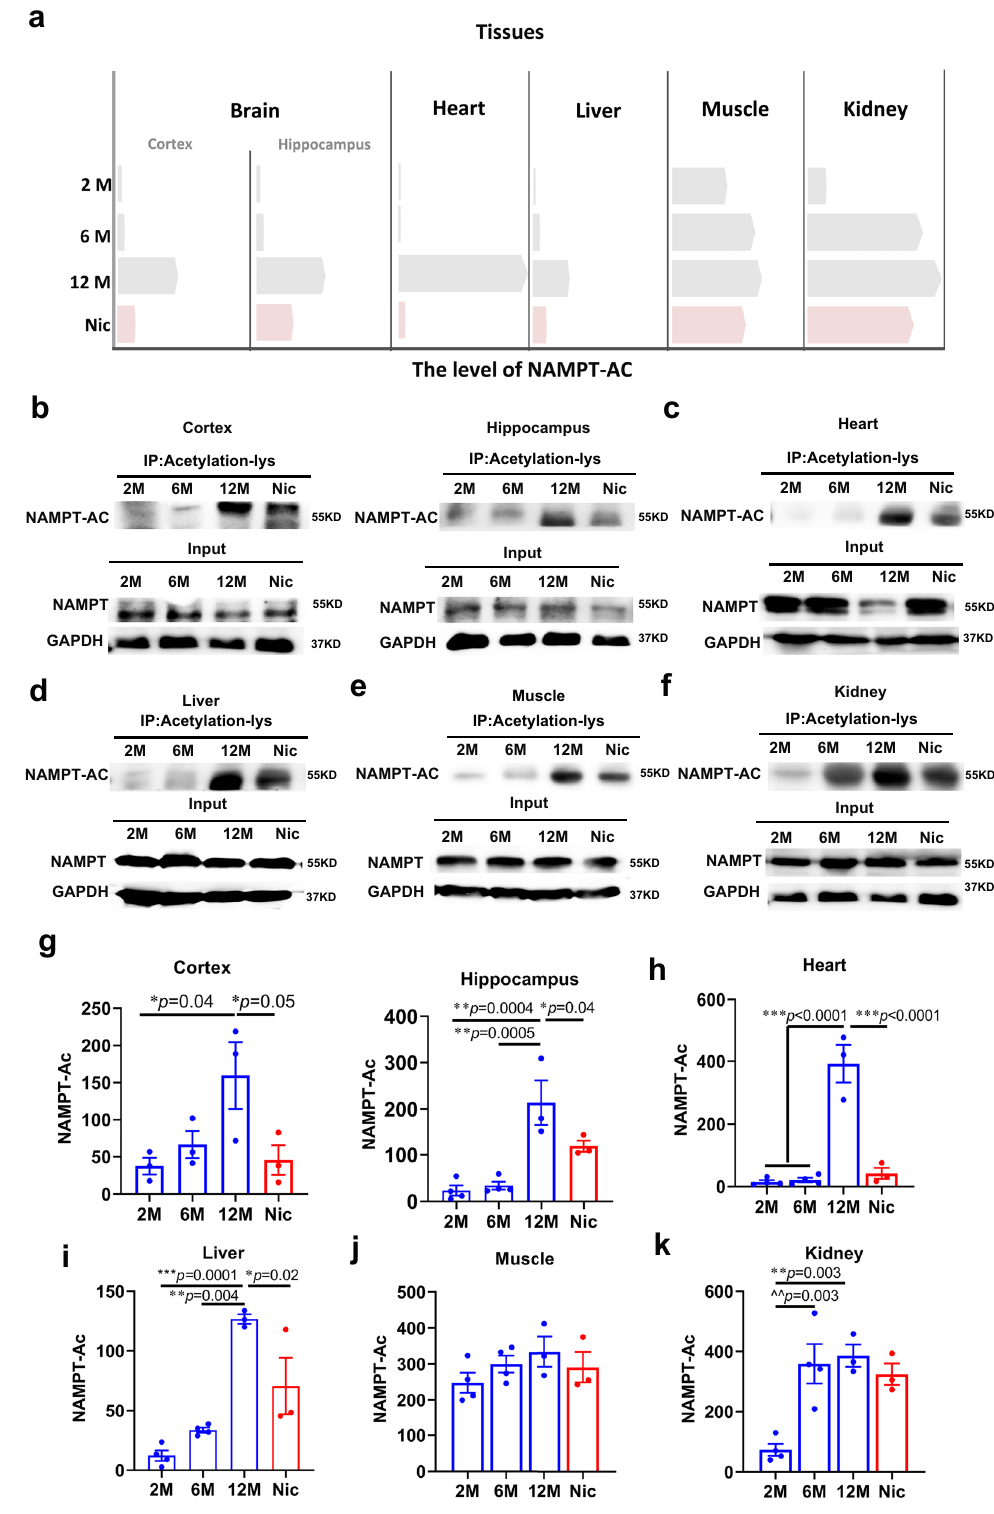
Fig. 2 | Nicotine increased NAMPT deacetylation in aged mice. a Schematic diagram of the changes in NAMPT acetylation levels and nicotine decreased NAMPTacetylationinvarioustissues(thebarsrepresentthemeanvalueofNAMPT acetylation). The acetylation levels of NAMPT in different tissues: b Cortex and Hippocampus, c Heart, d Liver, e Muscle, f Kidney. Statistical diagram of NAMPT